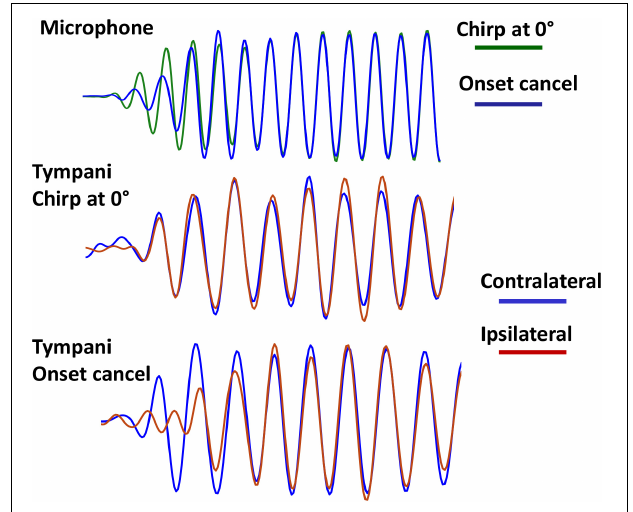
FIGURE 6 | Onset-cancelation tympanal responses. Upper traces show the onset of the stimulus waveforms recorded at the midline position of the fly (green – forward chirp alone; blue – chirp with impulses canceling initial onset). The rise-time of the stimulus waveform is delayed in the cancelation condition. Middle traces show the corresponding vibration responses for the two tympani for the forward chirp alone (simultaneous responses). Lower traces show tympanal vibration with onset cancelation. The impulse-ipsilateral tympanal response is